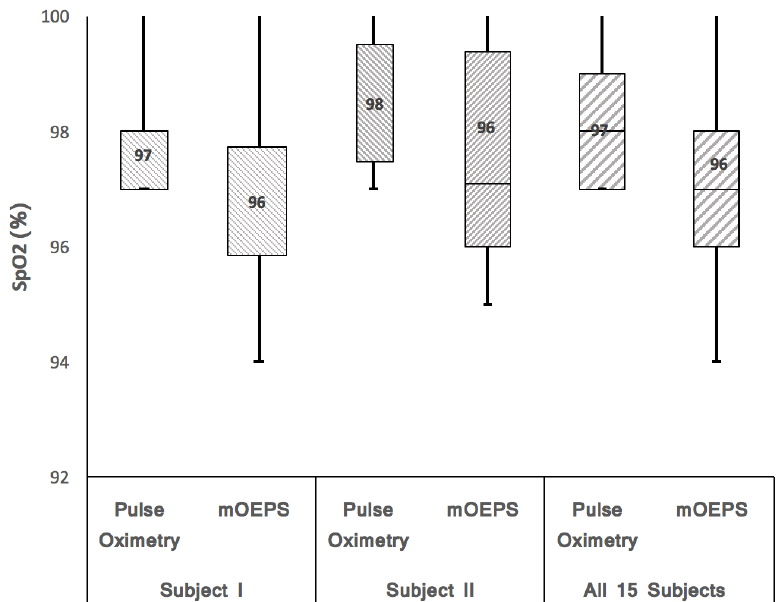
Figure 8. SpO 2 readings with box-and-whisker plots and median values of the pulse oximetry device and the green and orange illuminations of mOEPS. Subject I (Pulse Oximetry: 97% and mOEPS: 96%), subject II (Pulse Oximetry: 98% and mOEPS: 96%) and all 15 subjects readings (Pulse Oximetry: 98% and mOEPS: 98%). All SpO 2 data sets were processed with box-and-whisker procedures to obtain the lower, median and higher